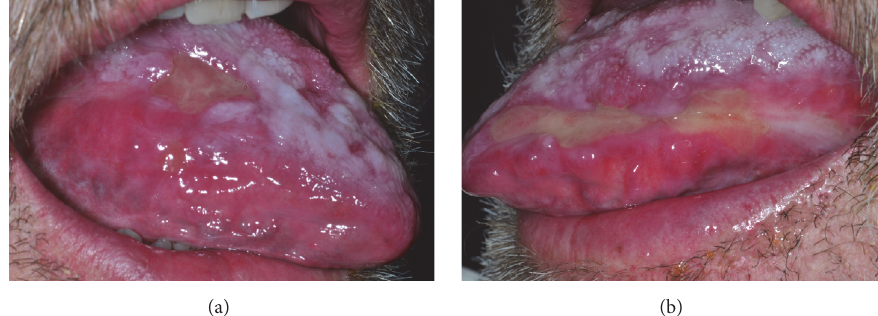
Figure 1: Erosive lesions presented in (a) and (b) lateral border of the